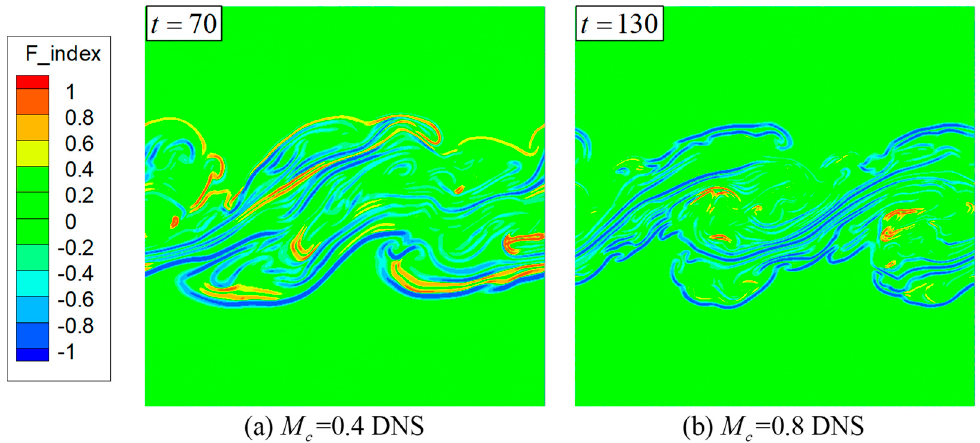
Figure 12. Instantaneous DNS results of the flame index calculated with hydrogen/air reaction for ( a ) M c = 0.4 case and ( b ) M c = 0.8 case, respectively.